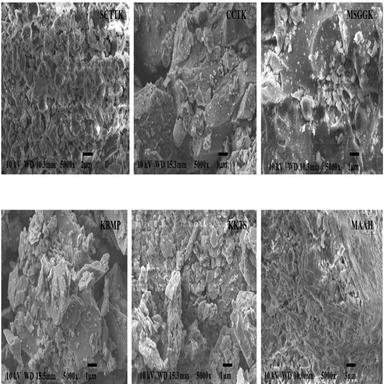
SEM images of monumental brick samples.